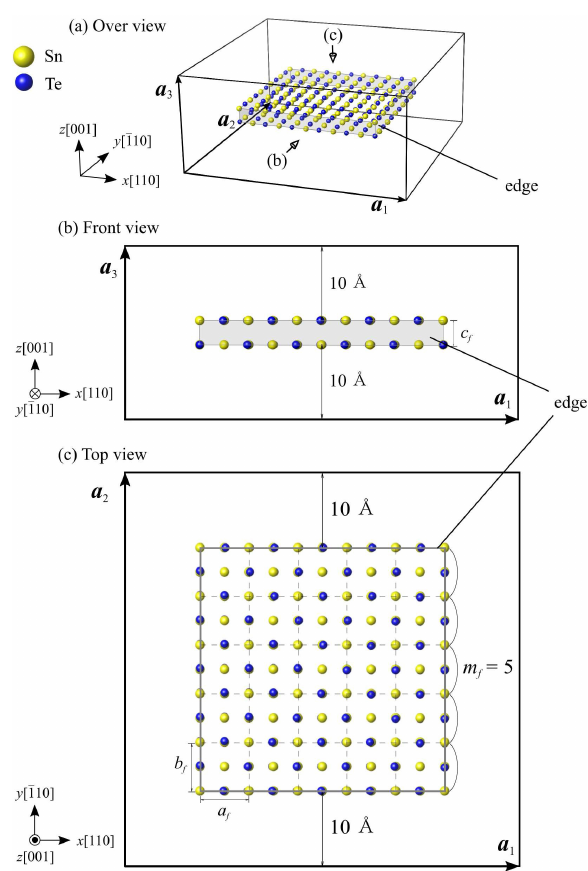
Figure 3. Simulation models of the SnTe nanoflake with a surface area of 5 × 5 unit cells. The gray area and solid lines indicate edges of the SnTe nanoflake. The solid boxes represent the simulation cells. a 1 , a 2 and a 3 indicate the simulation cell vectors.